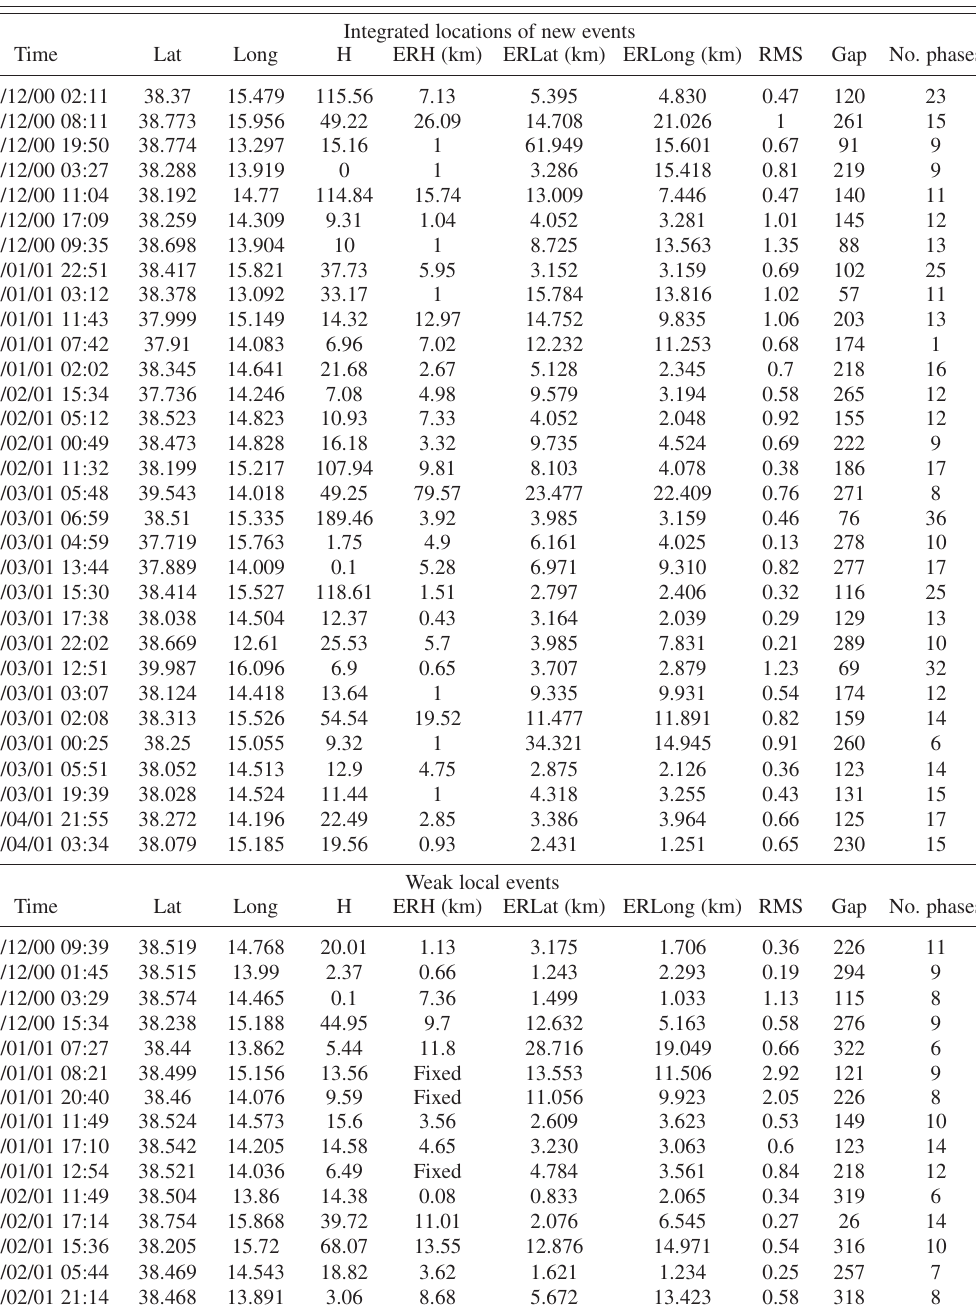
Table II. Locations parameters for categories «integrated locations of new events» and «weak local events».